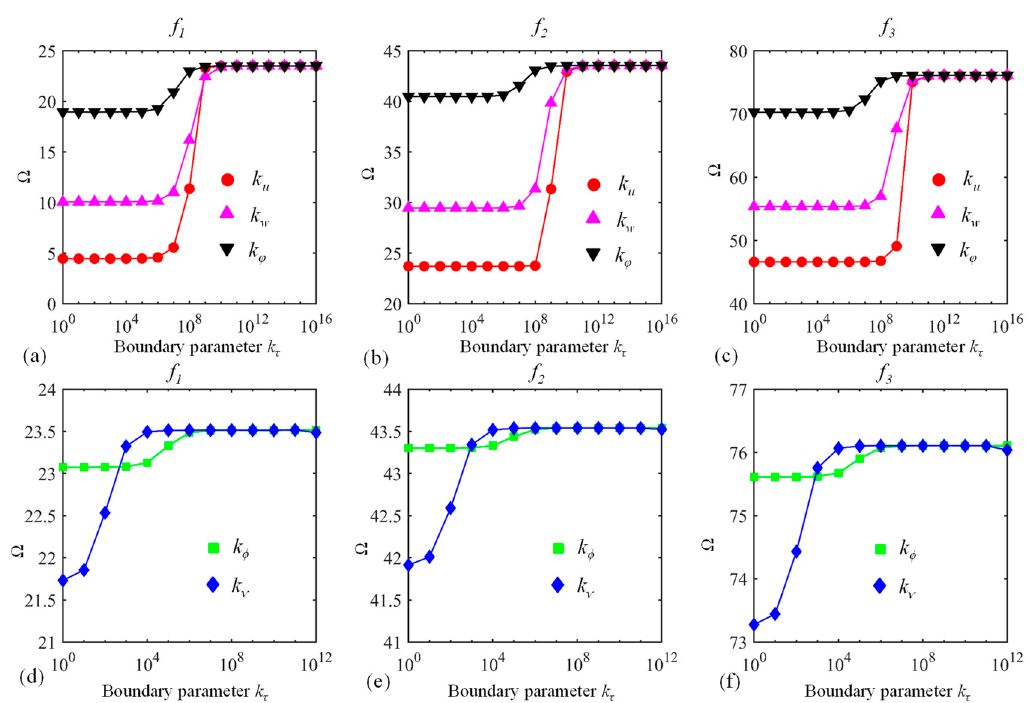
1 , f 2 , and f 3 ) are considered.